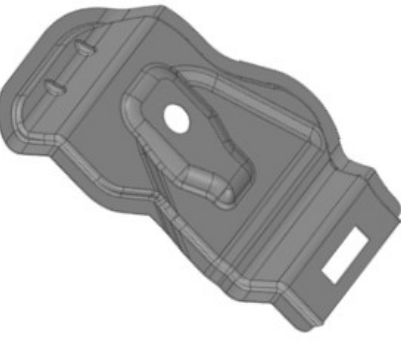
Figure 3. Example of sheet metal parts used in the industrial